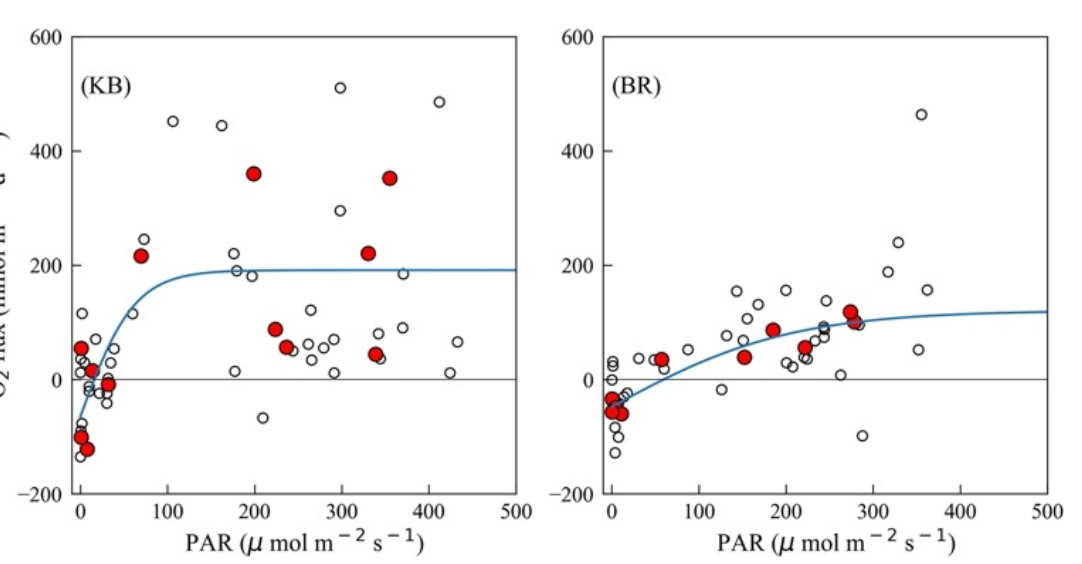
Figure 6. Hourly average O 2 flux (open bar) for 24 h and PAR (red line) in KB and BR. The bars represent standard errors.